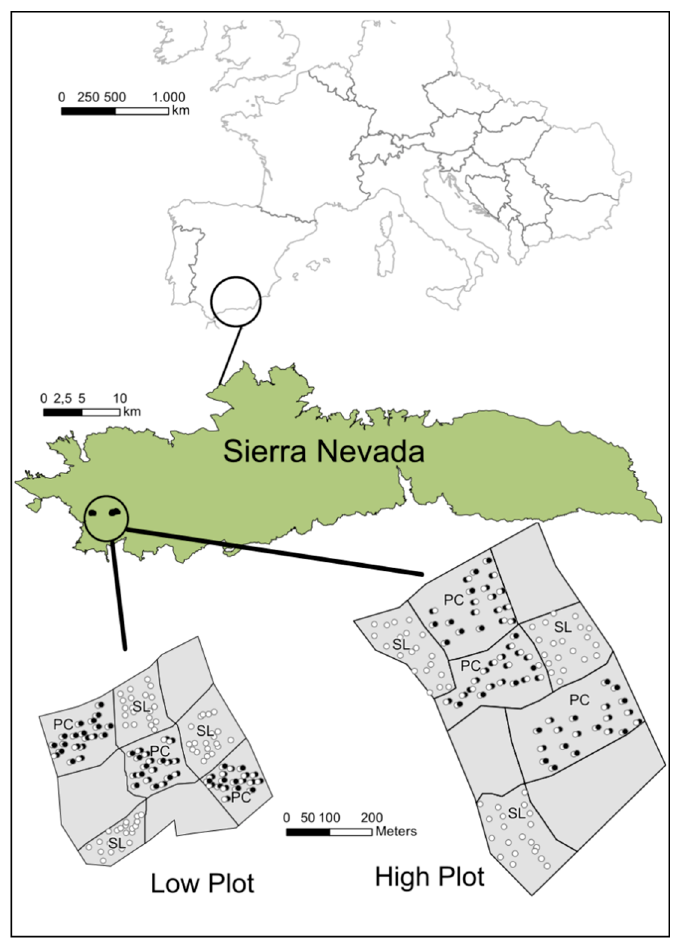
Figure 1. Location of the two study plots within Europe and the Sierra Nevada Natural Park. Each plot contained six subplots, which constituted three replicates of each of two post-fire treatments. SL = salvage logging; PC = partial cut. Black circles correspond to sampling points in the “under-logs” microhabitat and white circles in the “bare-soil” microhabitat.